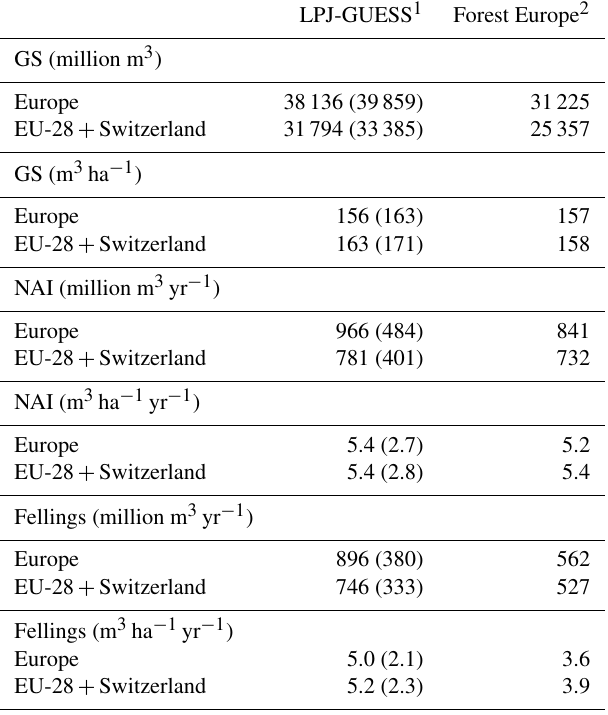
Table 4. Modelled and observed growing stock (GS) in European forests in 2010 and net annual increment (NAI) and fellings in forests available for wood supply (FAWS) in Europe for